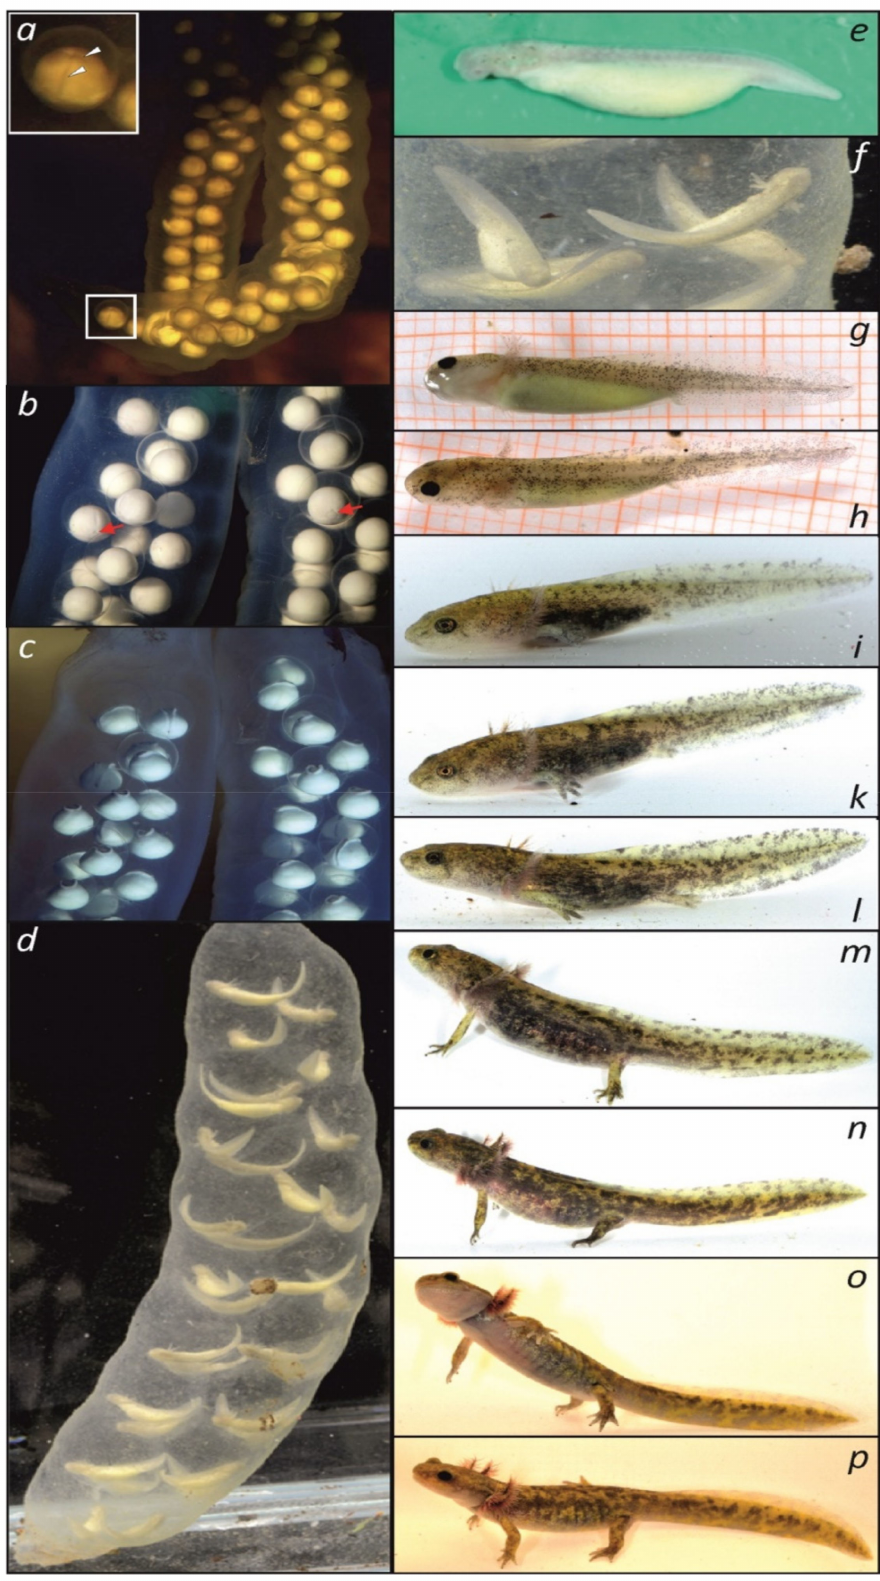
Figure 3. Development of Paradactylodon persicus (for staging see Table 1). ( a – c ) Egg sacs of descendants of Paradactylodon (topotypic P. gorganensis ), obtained at loc. 6 that reproduced in captivity at 6.5 ◦ C